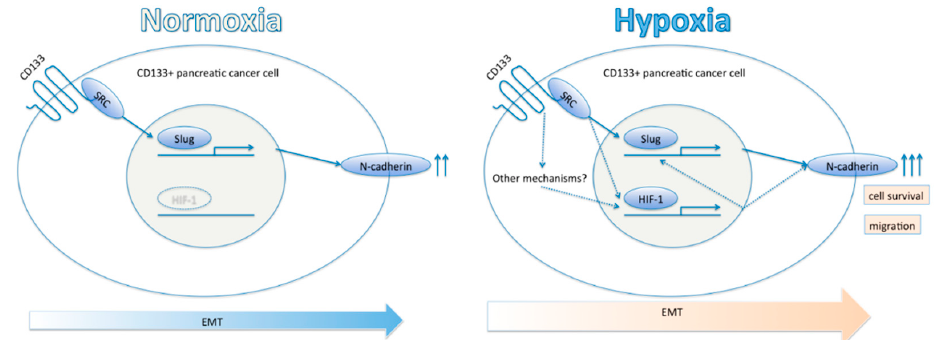
Figure 5. Proposed model for CD133-HIF-1 α axis in pancreatic cancer stem cells. CD133 positively stimulates HIF-1 α expression under hypoxia, and subsequent up-regulation of N -cadherin results in epithelial mesenchymal transition (EMT) phenomenon and tumor migration. Two and three arrows represent N-cadherin up-regulation.